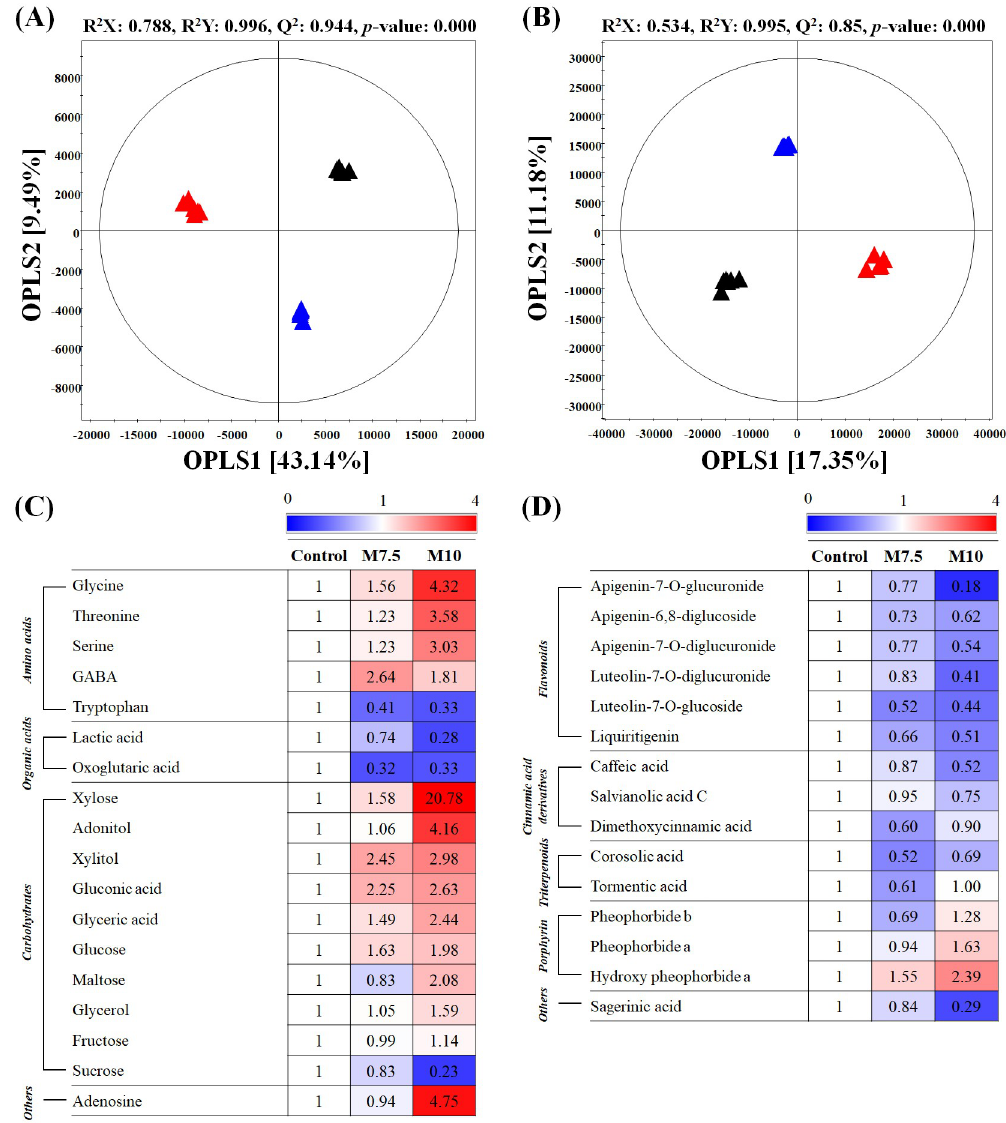
Fig 2. Orthogonal projection to latent structures-discriminant analysis (OPLS-DA)) score plots of Perilla frutescens leaves under control and magnesium oversupply derived from GC-TOF-MS (A) and UHPLC-LTQ-Orbitrap-ESI-MS/MS (B). Heat map analysis of P . frutescens leaves under control and magnesium oversupply based on GC-TOF-MS (C) and UHPLC-LTQ-Orbitrap-ESI-MS/MS (D) data. The heat map represents the relative abundance of significantly discriminant primary and secondary metabolites (VIP > 0.7, p -value < 0.05) based on the OPLS-DA model. The relative content is presented as fold-changes normalized by the control value. Symbols indicated: ▲ , Control; ▲ , M7.5; ▲ , M10. M7.5, magnesium supply at 7.5 times the control; M10, magnesium supply at 10 times the control. Three different plants were used as biological replicates. observed a decrease in the relative content of tryptophan, some organic acids (lactic acid and oxoglutaric acid), sucrose, flavonoids (apigenin-7-O-glucuronide, apigenin-6,8-diglucoside, apigenin-7-O-diglucuronide, luteolin-7-O-diglucuronoide, luteolin-7-O-glucoside, and liquir- itigenin), cinnamic acid derivatives (caffeic acid, salvianolic acid C, and dimethoxycinnamic acid), triterpenoids (corosolic acid and tormentic acid), and sagerinic acid in the Mg-treated groups, compared with the control.